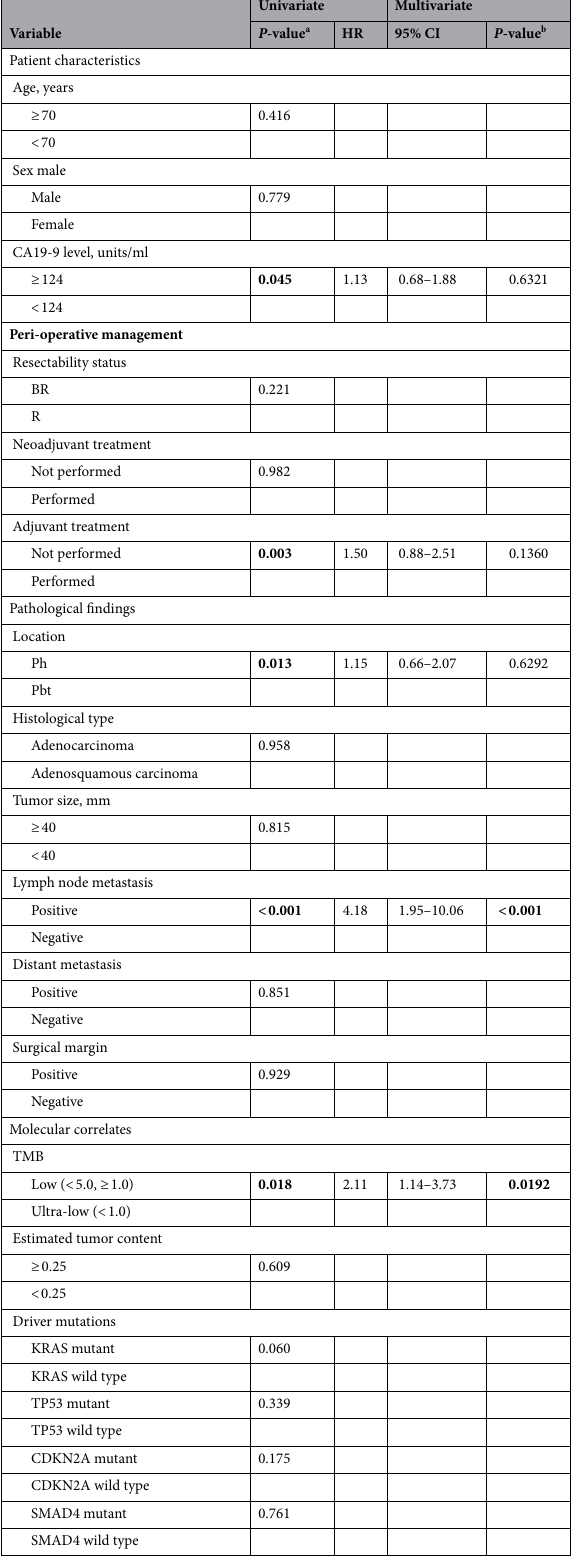
Table 3. Univariate and multivariate analyses for the overall survival after surgery. HR hazard ratio, CI confidence interval, BR borderline resectable, R resectable, Ph pancreatic head, Pbt pancreatic body and tail, TMB tumor mutation burden. Significant values are in bold. a Kaplan-Meier method. Significance was determined by the log-rank test. b Multivariate survival analysis was performed using Cox’s proportional hazard